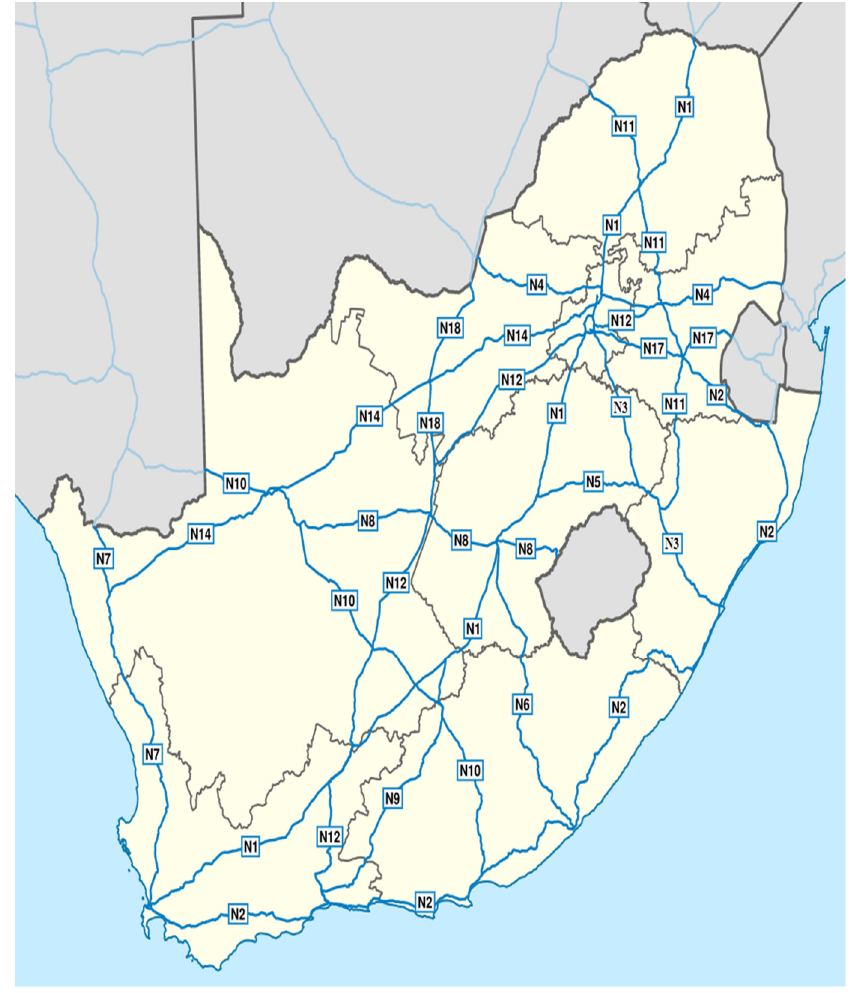
Figure 2. The Freeways in South Africa Transportation System. Note. 𝑁 (cid:2869) is Black Circle, 𝑁 (cid:2871) is Light Green Circle, 𝑁 (cid:2869)(cid:2870) is Light Blue 𝑁 (cid:2869)(cid:2872) is Indigo, 𝑁 (cid:2869)(cid:2875) is Yellow .